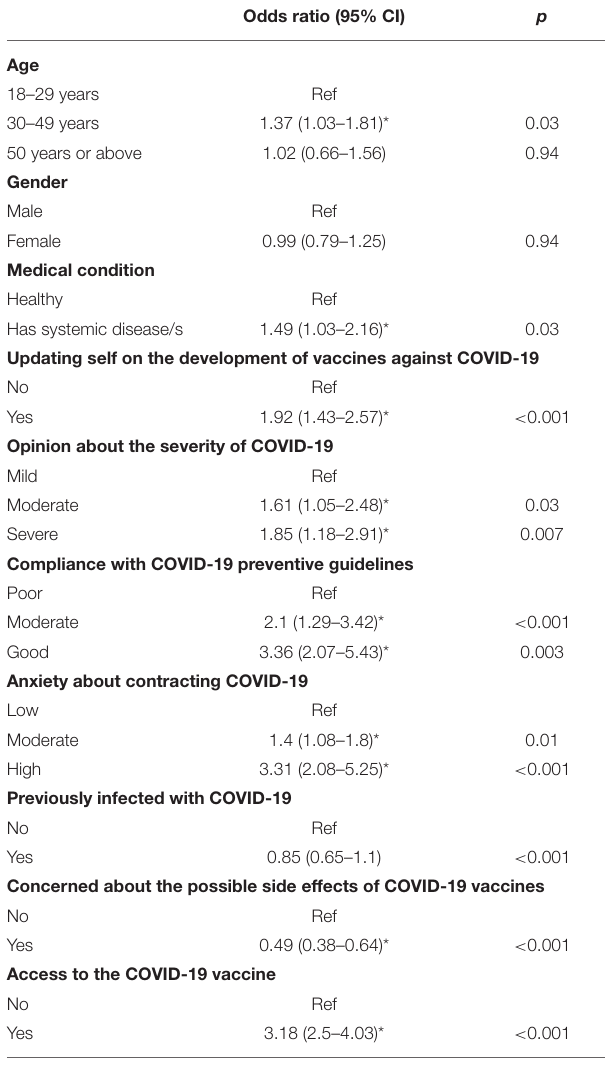
TABLE 5 | Predictors of intention to